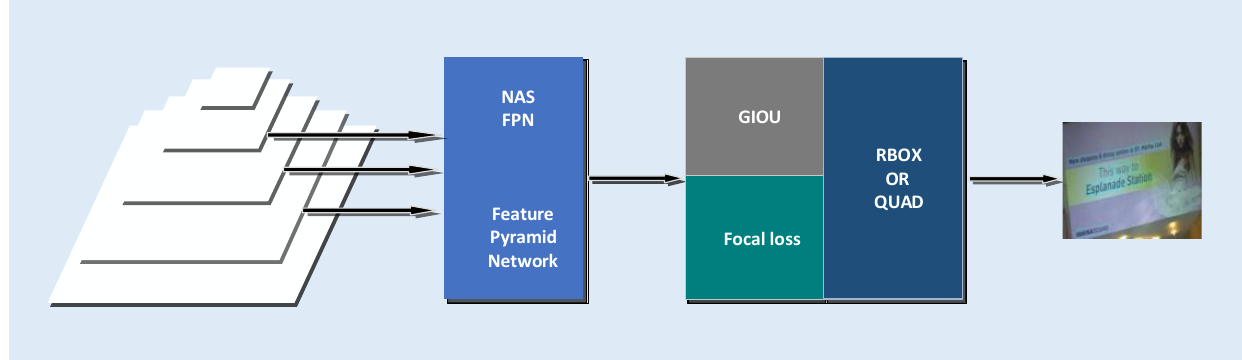
Figure 3. Text detection model based on NEAST.